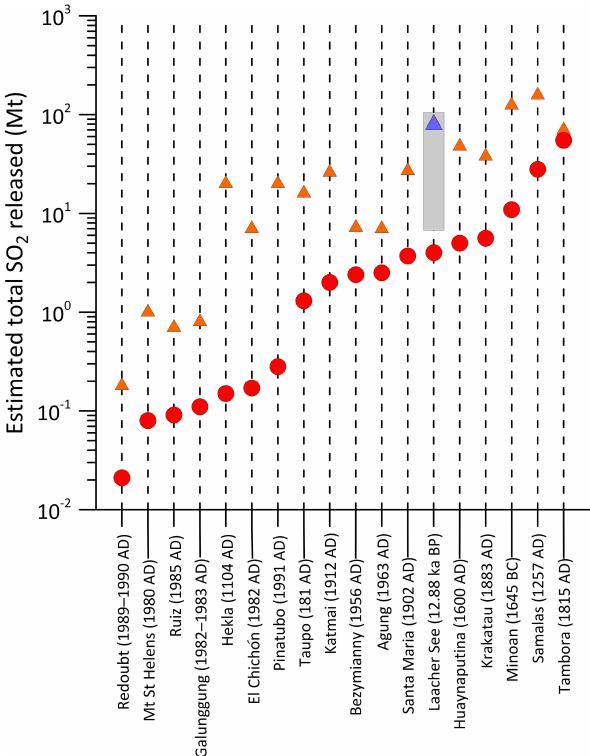
Figure 2. The SO 2 yield of climatologically significant late Holocene eruptions (Shinohara, 2008). Red circles represent petro- logic estimates of SO 2 release, and orange triangles represent es- timated actual values, calculated from either satellite or ice core data (Shinohara, 2008). The grey bar represents the range of values for the Laacher See eruption as suggested by Textor et al. (2003), Schenk et al. (2018), and Bahr et al. (2018), and the blue triangle in the Laacher See column represents the total estimated SO 2 emitted by the Laacher See eruption (83.6Mt) assuming that the actual SO 2 emitted is 20.9 times the petrologic estimate, calculated here as the mean value of 17 non-basaltic explosive eruptions (the 16 listed in Shinohara (2008) plus the AD1257 Samalas eruption; Vidal et al., 2016).